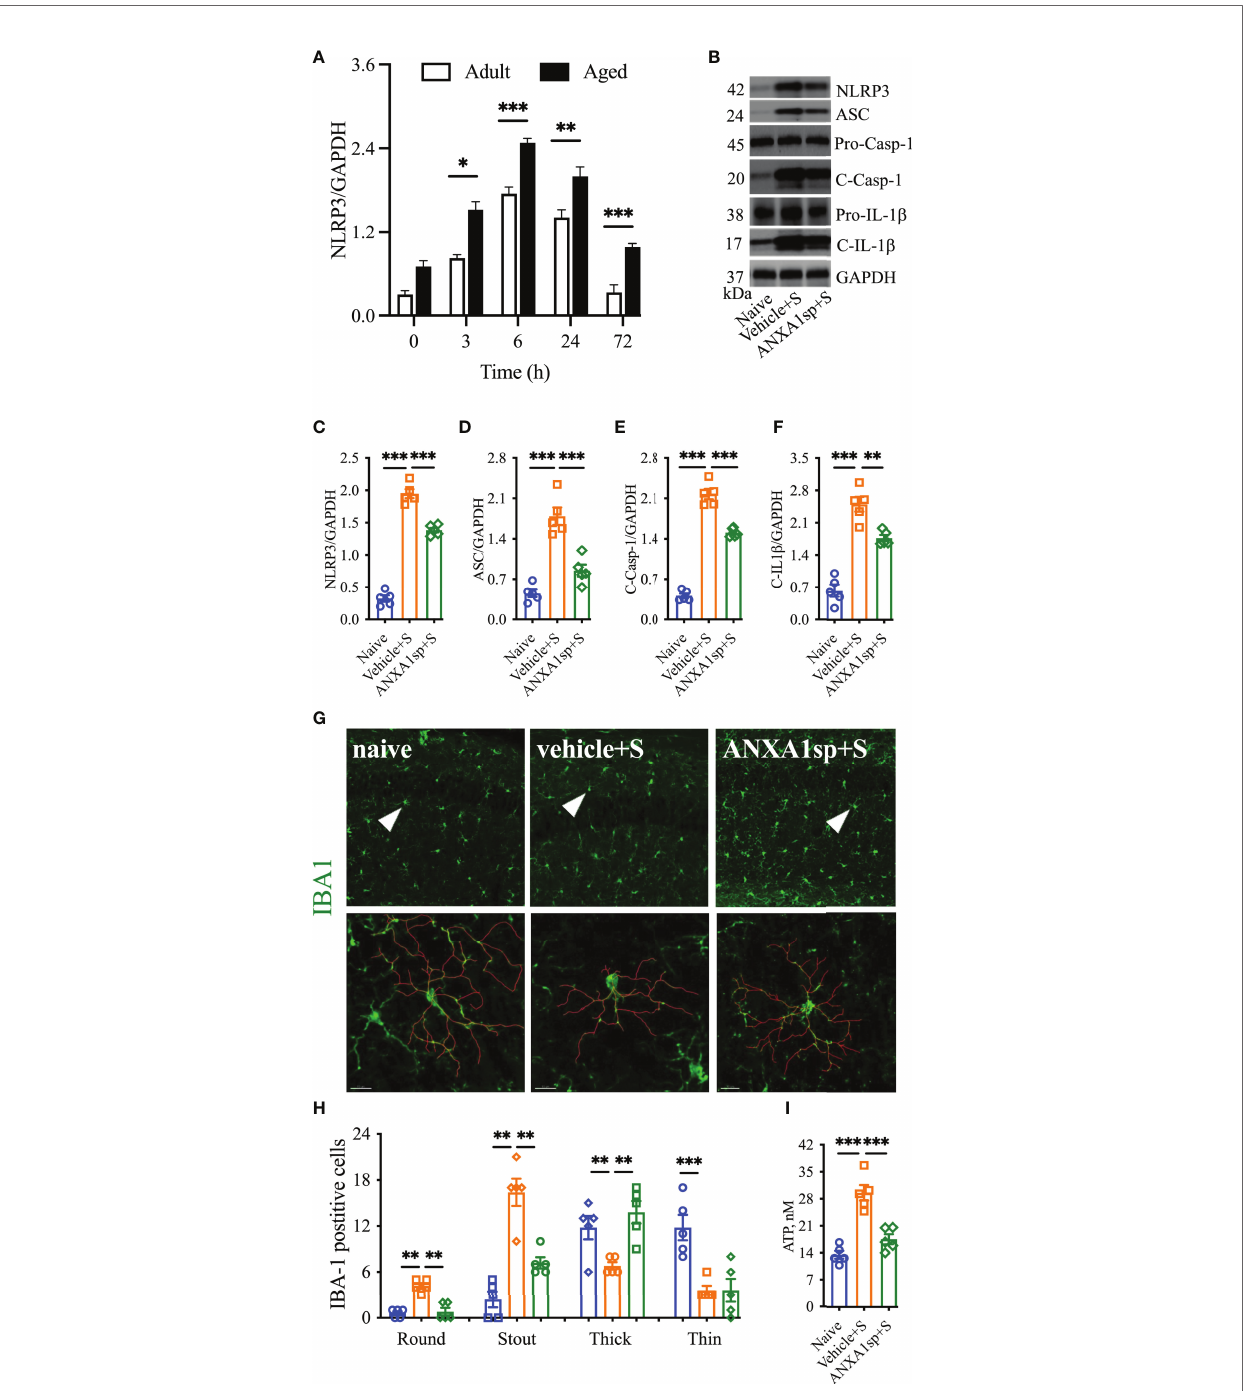
FIGURE 6 | Effects of ANXA1sp on NLRP3 in fl ammasome and microglial morphology in aged mice after surgery. The hippocampal NLRP3 in fl ammasome complex was signi fi cantly activated in a time-dependent manner in aged mice after orthopedic surgery, with older mice showing a signi fi cantly higher baseline compared to adult mice (A) . Hippocampal NLRP3 in fl ammasome activation (B – F) was attenuated in aged mice treated with ANXA1sp (1 mg/kg, ip) 30 min before orthopedic surgery (same dose and timepoint as in the adult mice). Similarly, microglial activation in the CA1 area was reduced 24 h after surgery (G, H) , especially improving ameboidal morphologies (round, stout, and think). Three representative areas/mice were used for quanti fi cation and one single microglia was represented in the reconstruction (red indicates fi lament tracing). Hippocampal ATP expression (I) was also restored in aged mice treated with ANXA1sp. Data are presented as mean ± SEM. n = 5. ** P < 0.01, *** P < 0.001, compared to naïve or vehicle controls. Analyzed by one-way ANOVA with Tukey ’ s multiple comparisons test. Scale bar: 20 m m. Representative data are from two independent experiments. * P <